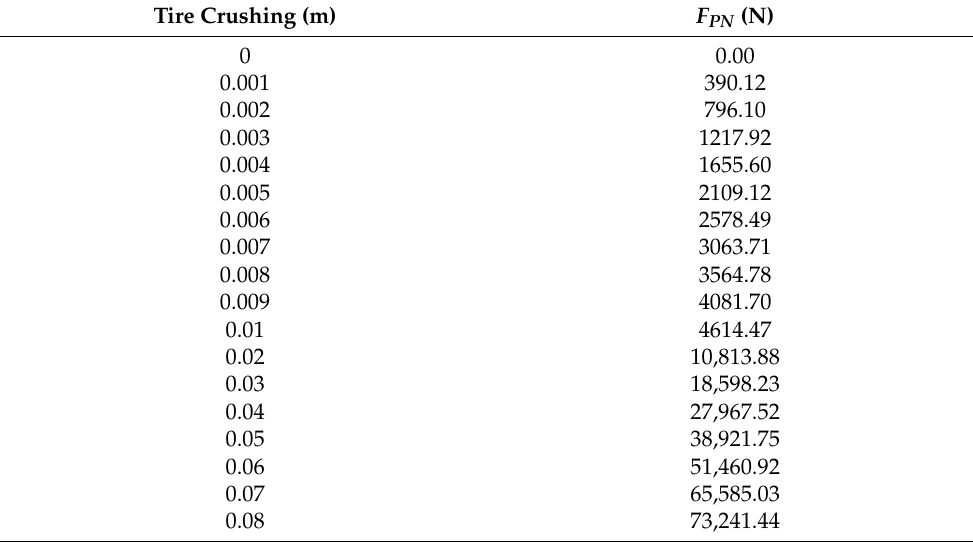
Table A2. Tire mechanical properties ( F PN vs. tire crushing at nominal inflation